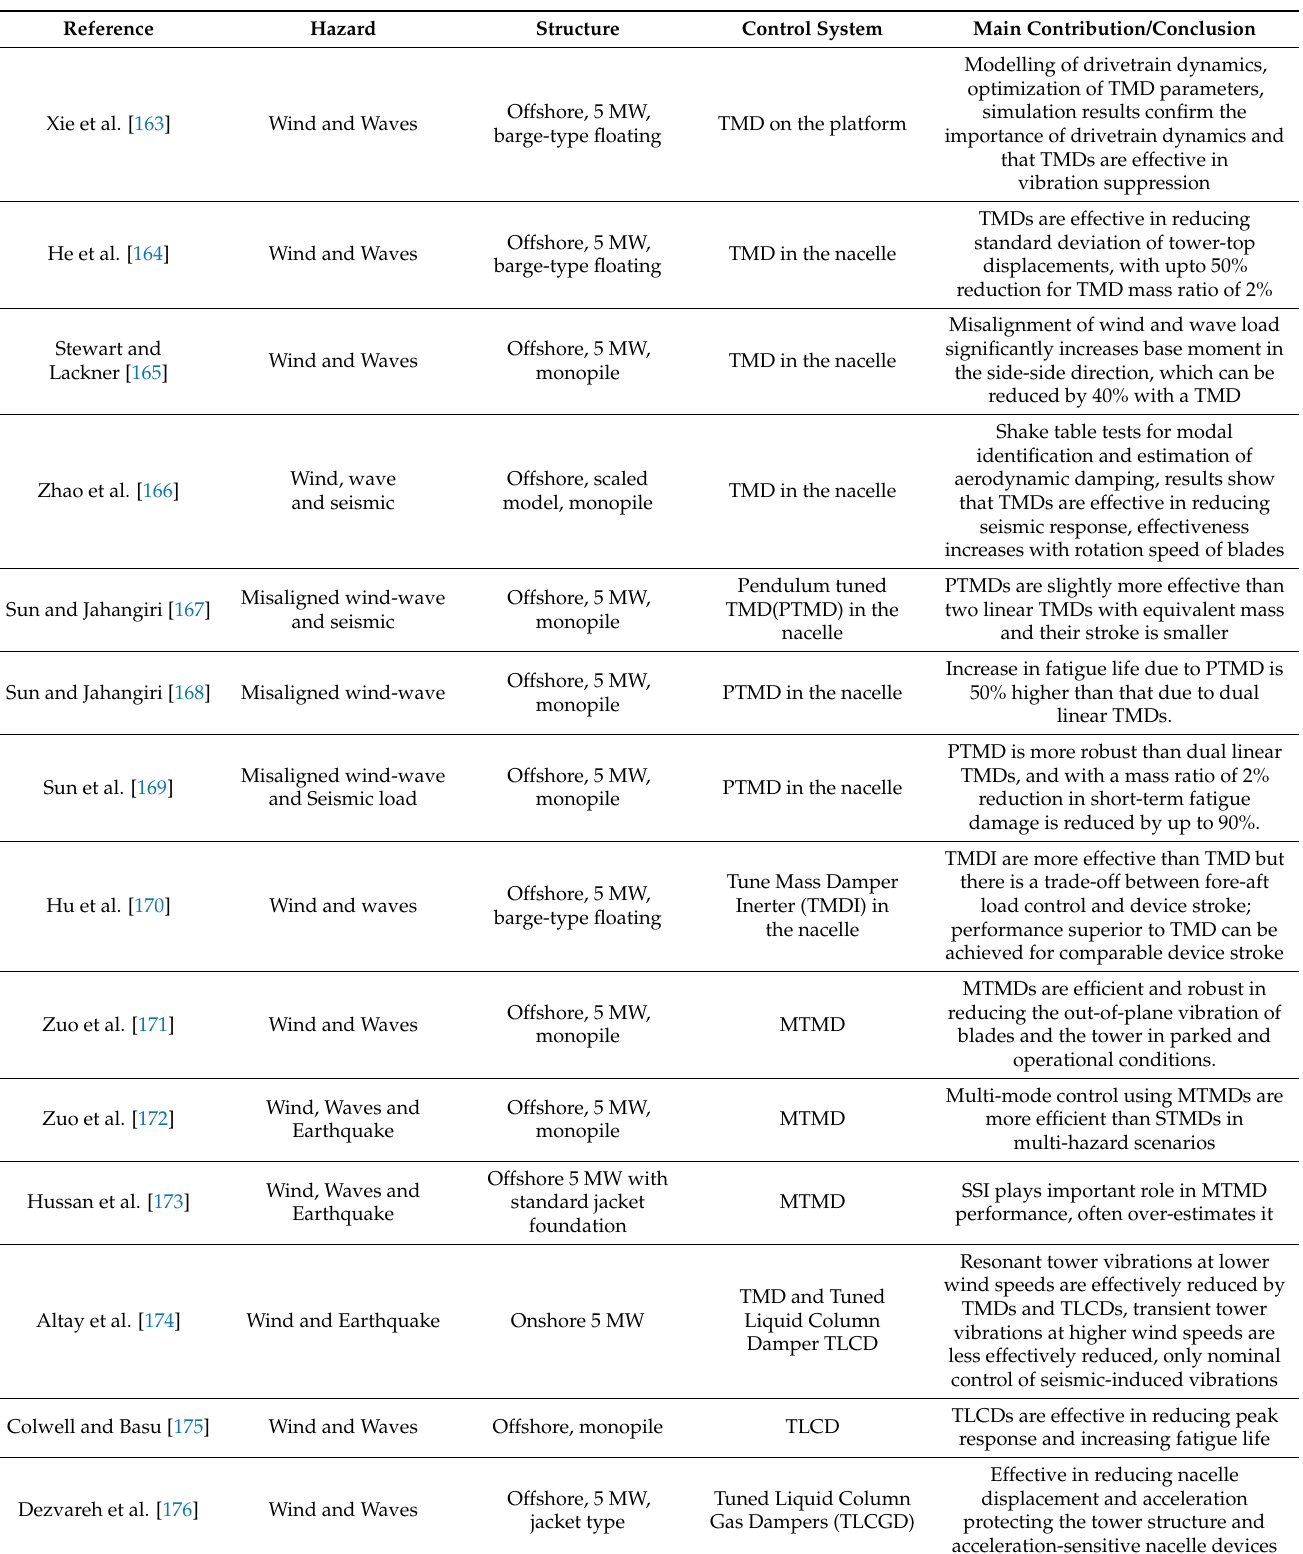
Table 3. A summary of published works on vibration control of wind turbine structures subjected to